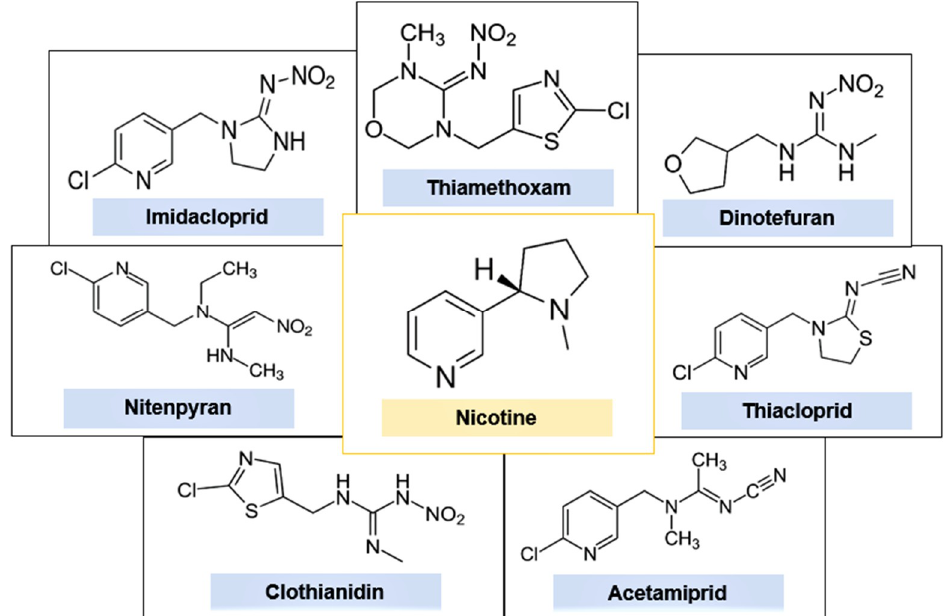
Figure 1. Chemical structures of nicotine and the neonicotinoid insecticides.